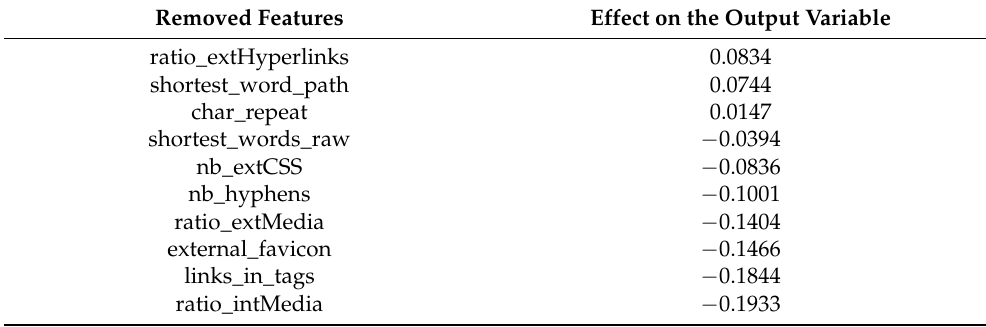
Table 10. List of features removed using MICe TICe and their effect on the output variable on dataset 2.